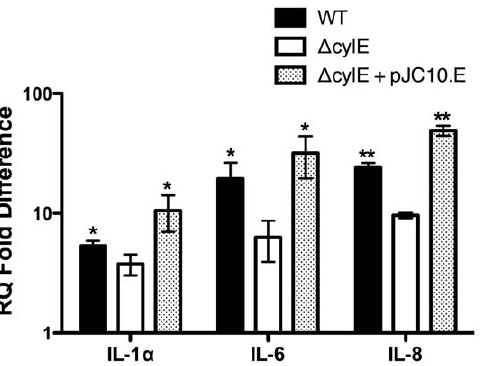
Figure 3. GBS b H/C is dispensable for establishment of UTI in a murine model . 6–8 week old female C57/Bl6J mice were infected with WT or D cylE GBS strains separately by transurethral catheterization and colonization assessed at 24 h. No difference was observed in the number of CFUs recovered from bladders, kidneys or urine comparing WT (filled shapes) with D cylE (open shapes) GBS.